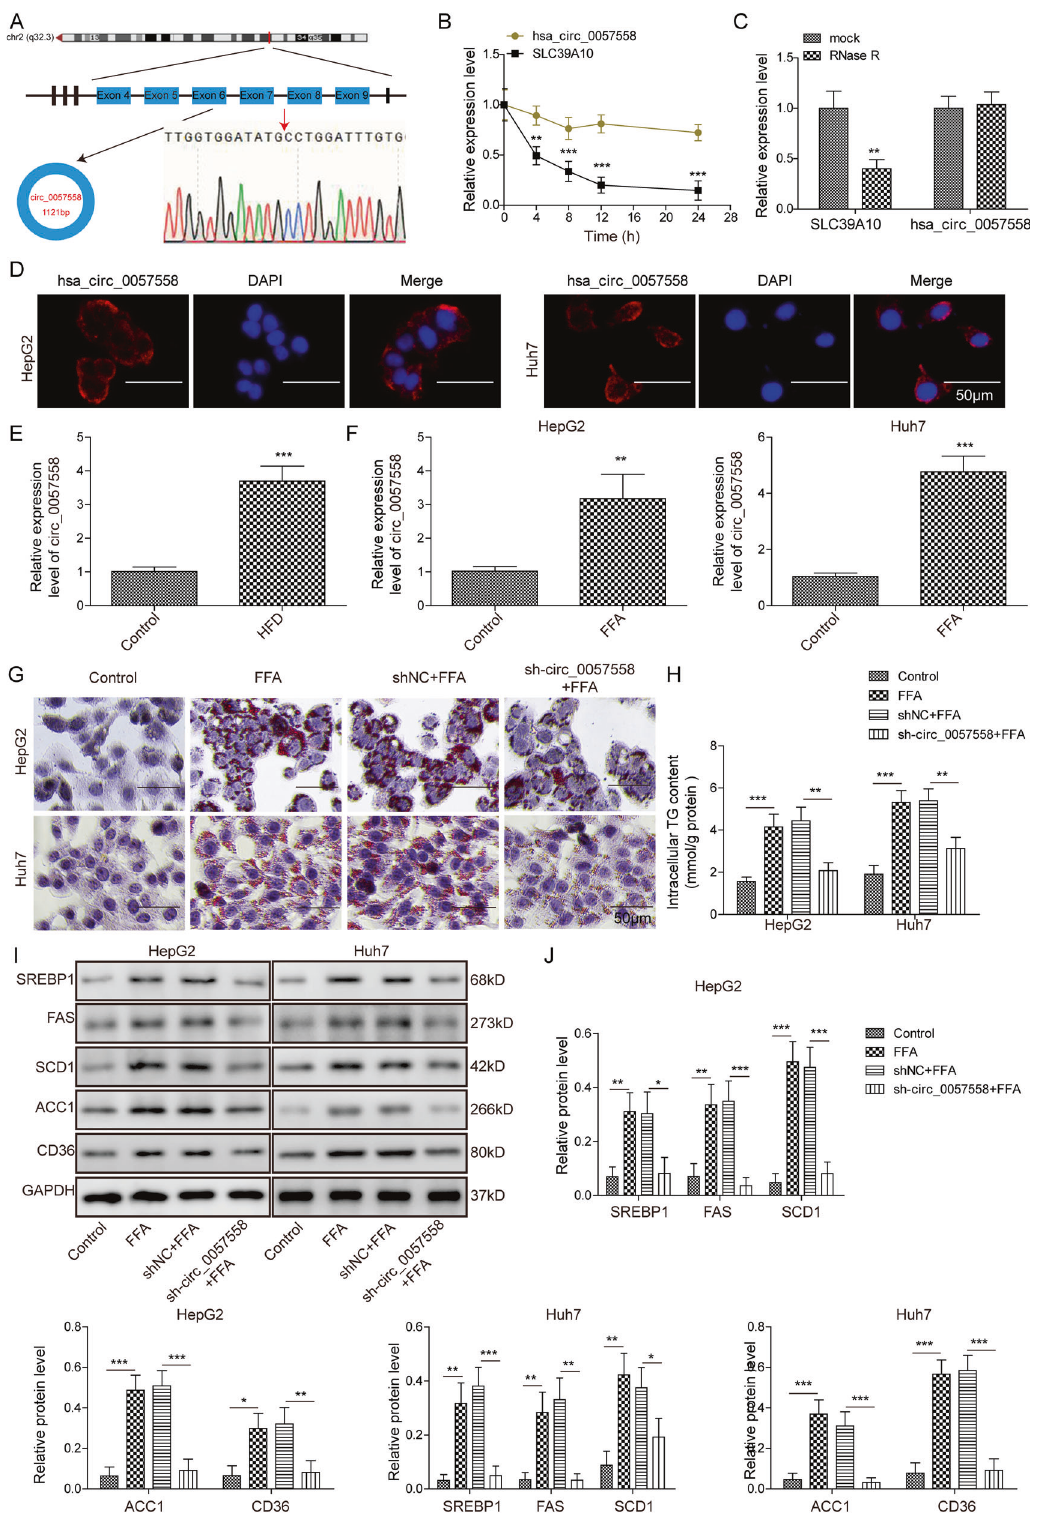
Fig. 5 Circ_0057558 was elevated in NAFLD and knockdown circ_0057558 inhibited lipogenesis. A The feature of circ_0057558 and Sanger sequencing result. B Relative expression levels of circ_0057558 and SLC39A10 at the indicated time after antinomycin D treatment. C Relative expression levels of circ_0057558 and SLC39A10 after RNase R treatment. D FISH analysis of subcellular localization of circ_0057558. E circ_0057558 level in HFD-fed mice and control mice. F circ_0057558 level in cells treated with FFA or control. G Representative oil-red o staining images of cells transfected with sh-circ_0057558 or sh-NC following FFA or control treatment. H Secreted TG level in cells with the transfection of sh-circ_0057558 or sh-NC following FFA or control treatment. I Protein levels of lipogenesis-related proteins in cells transfected with sh-circ_0057558 or sh-NC following FFA or control treatment. J Quanti fi cations of I . * p < 0.05, ** p < 0.01, and *** p <